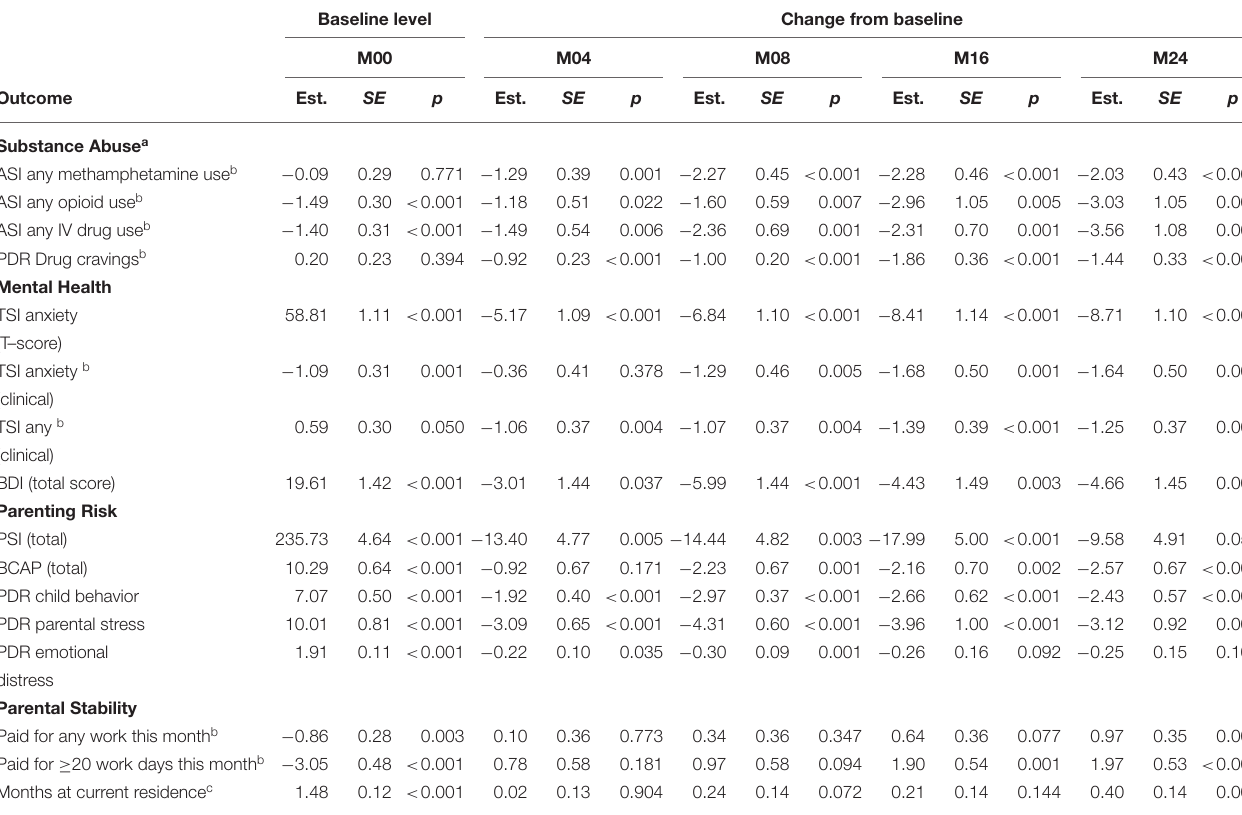
TABLE 2 | Mixed–effects regression model estimates for all outcomes. Baseline level Change from baseline M00 M04